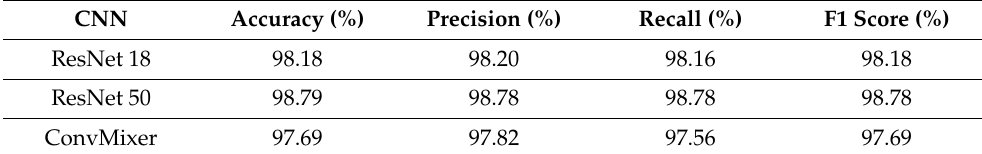
Table 3. Average 10-FCV performance evaluation metrics for 132,968 spectrogram images.